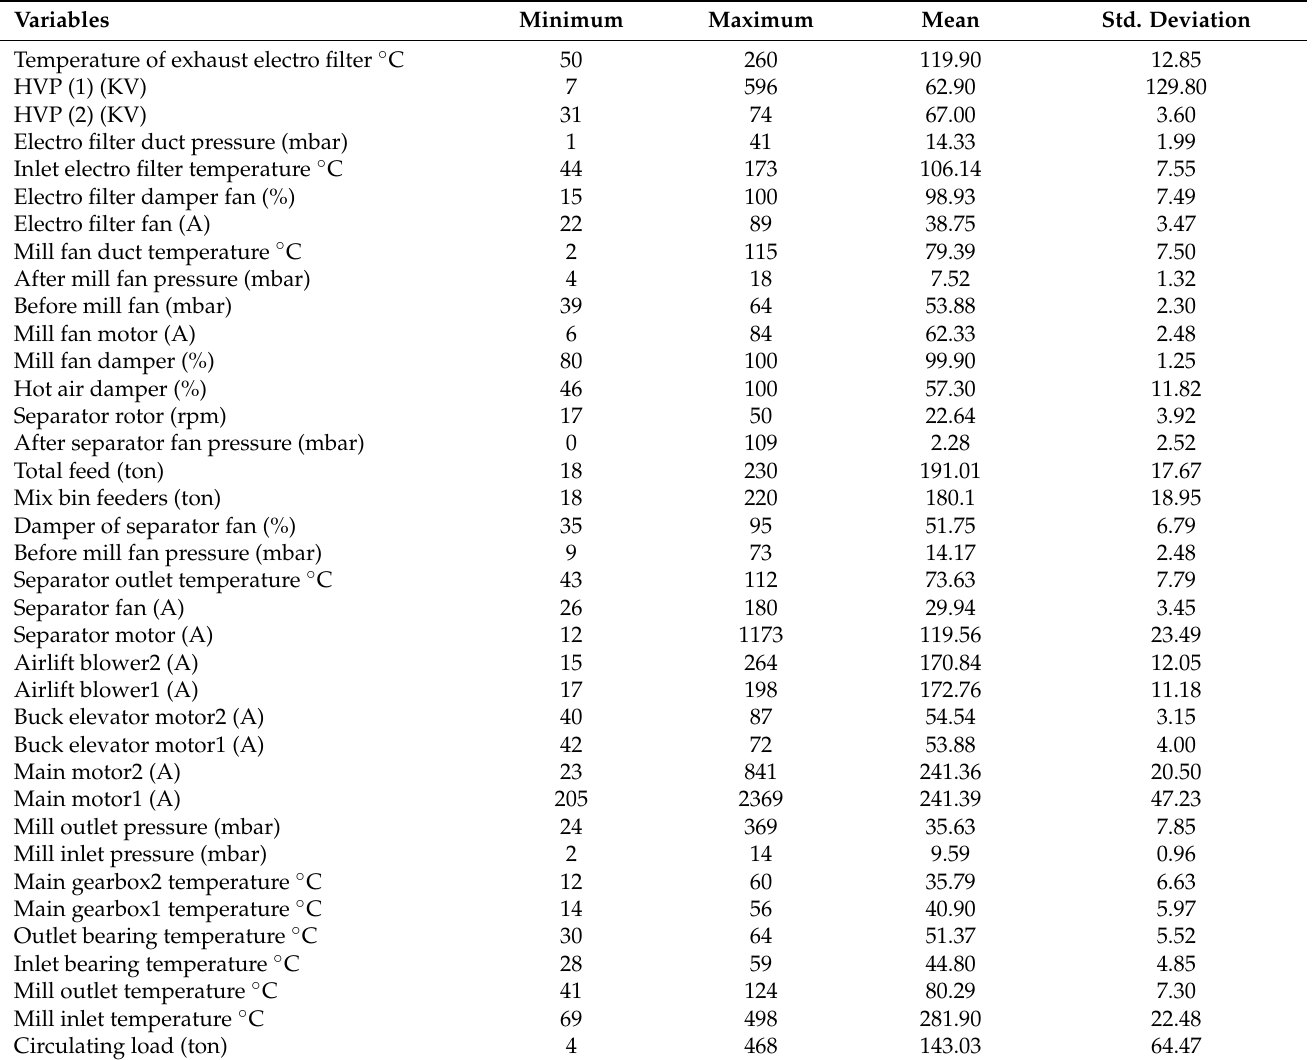
Table 1. Descriptive statistics of monitored variables in the